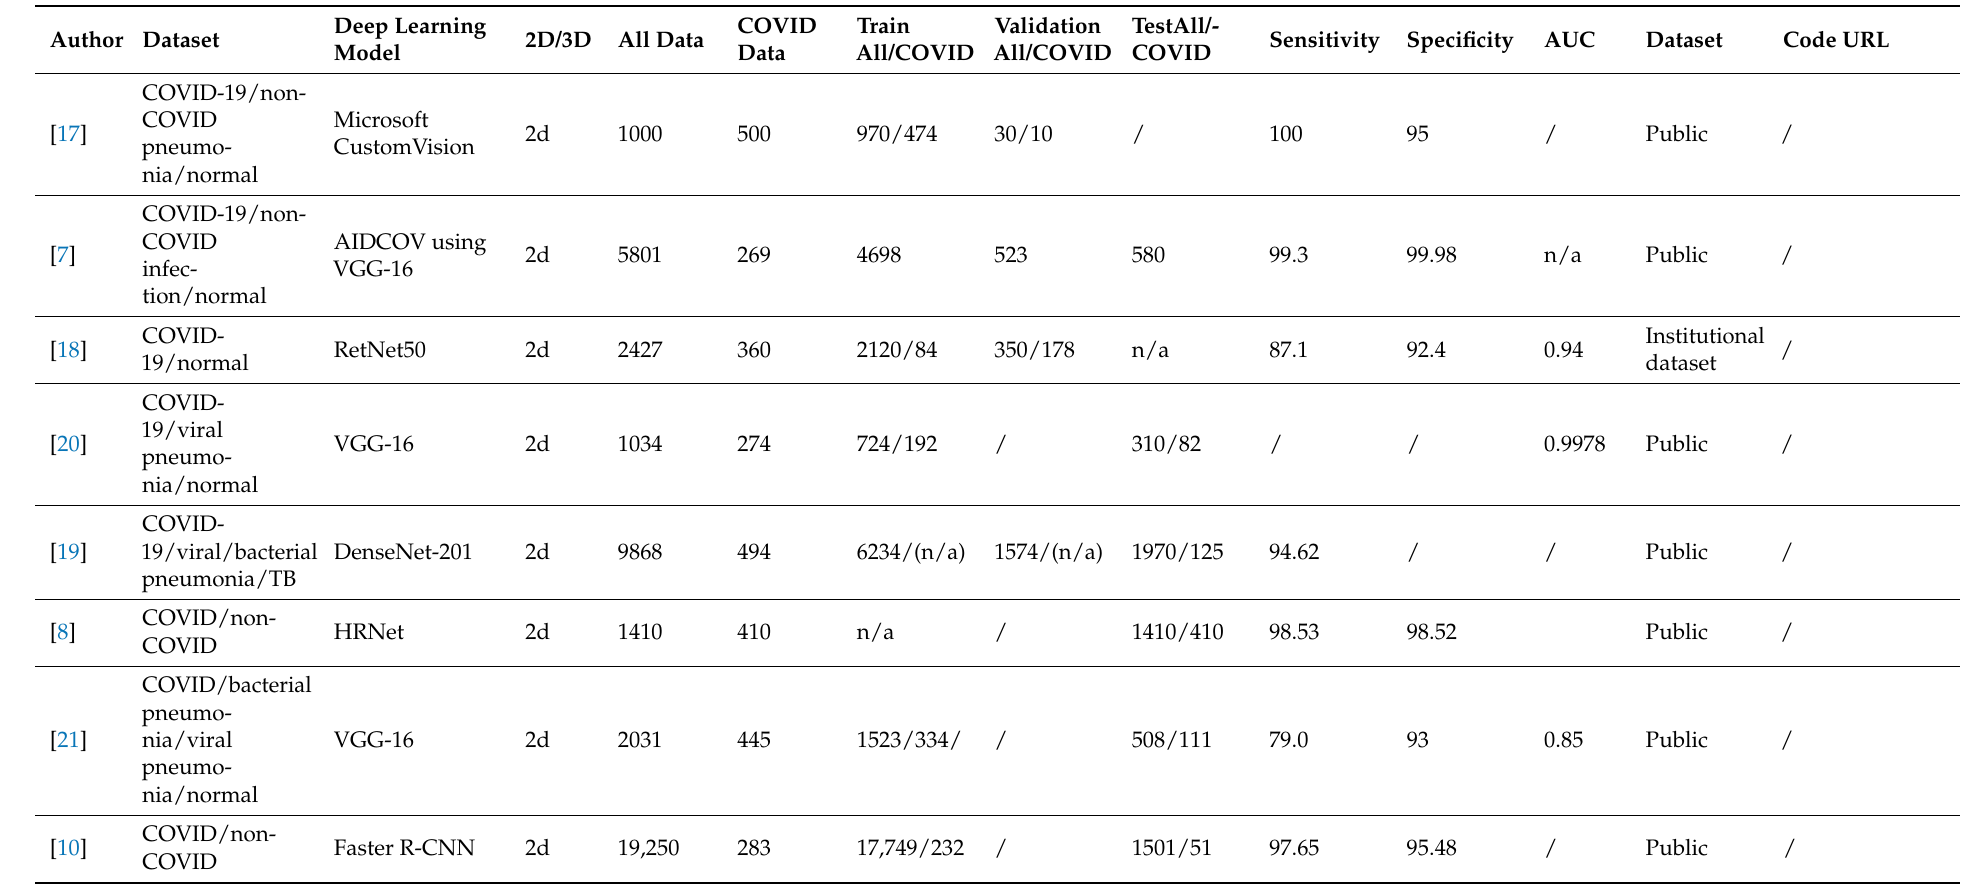
Table 3. Summary of results from AI Studies for chest X-ray COVID-19